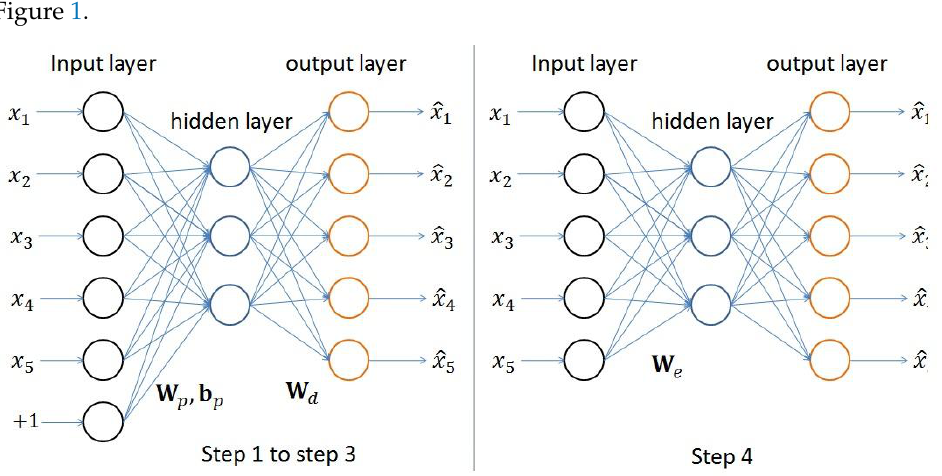
Figure 1. The training process of the autoencoder forward propagation